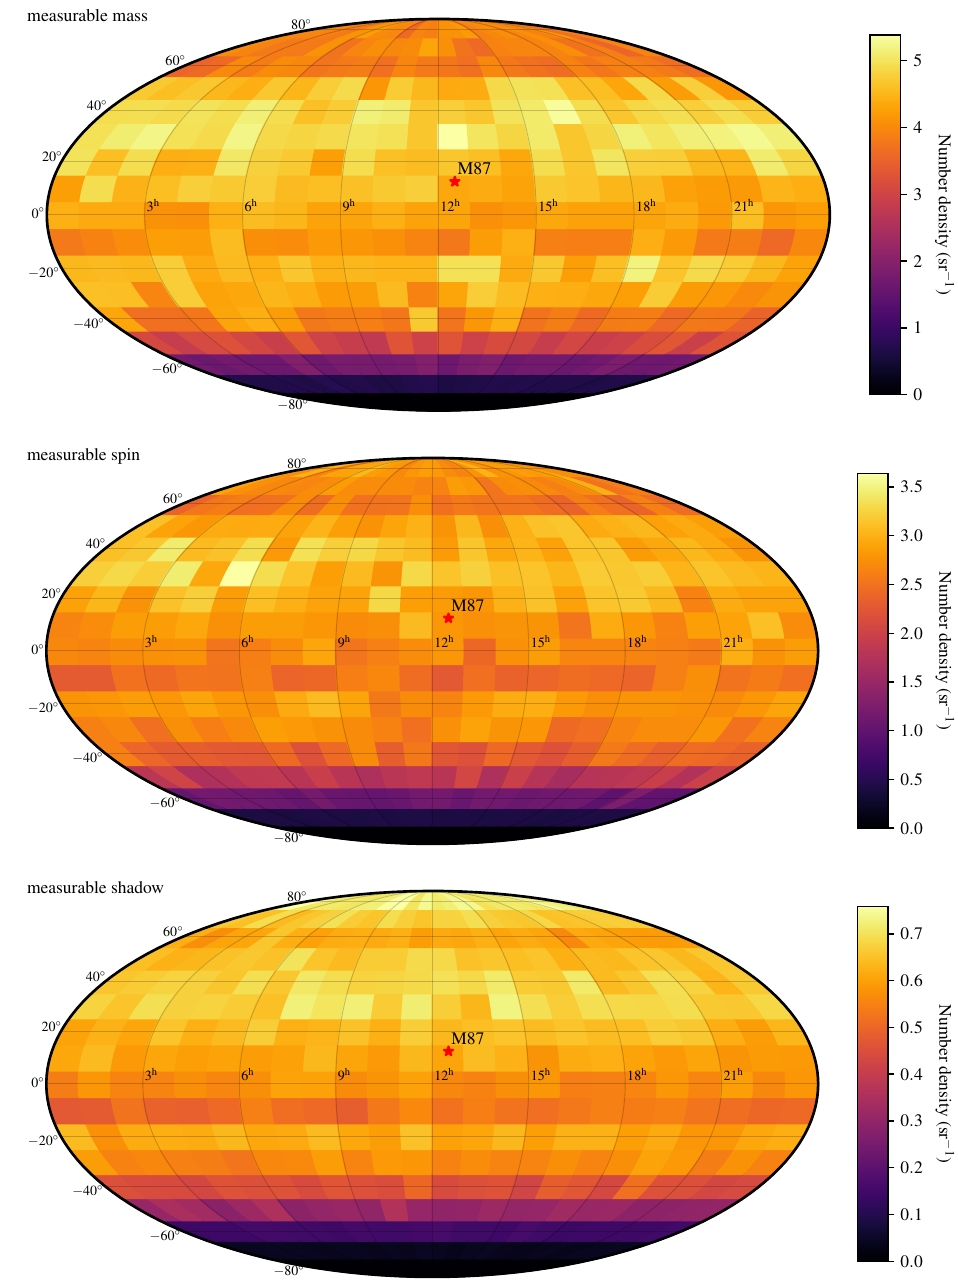
Figure 2. Estimated sky density of SMBHs with measurable masses (top), spins (middle), and shad- ows (bottom), as a function of right ascension and declination. These estimates have been determined according to the criteria outlined in Section 4, and they assume an underlying distribution of observ- able SMBHs from Pesce et al. [19]. The stochastic variations seen from pixel to pixel are primarily the result of sampling noise. The location of M87* is marked with a red